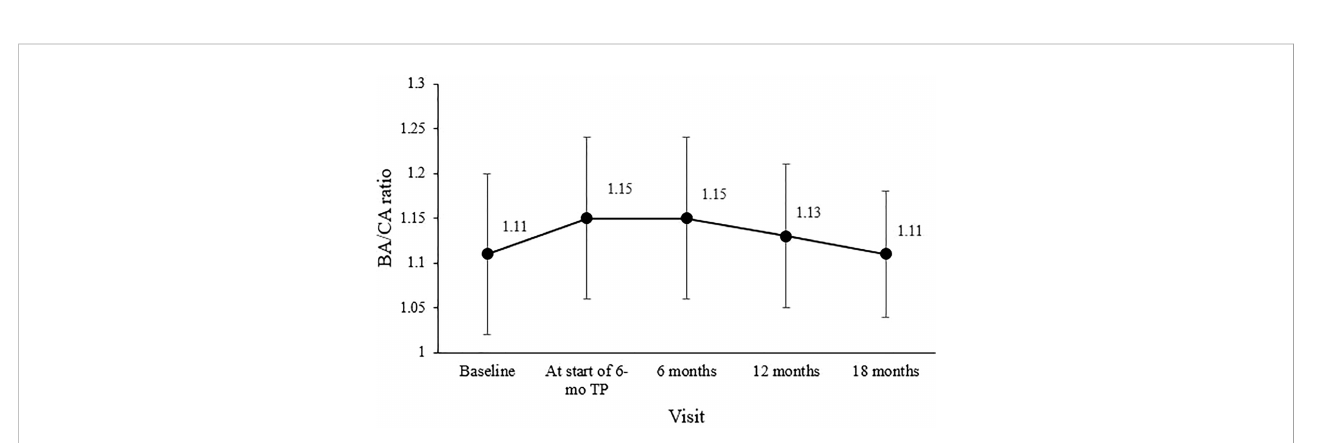
FIGURE 2 Changes in the mean bone age/chronological age (BA/CA) ratio during treatment. The overall signi fi cance was p =